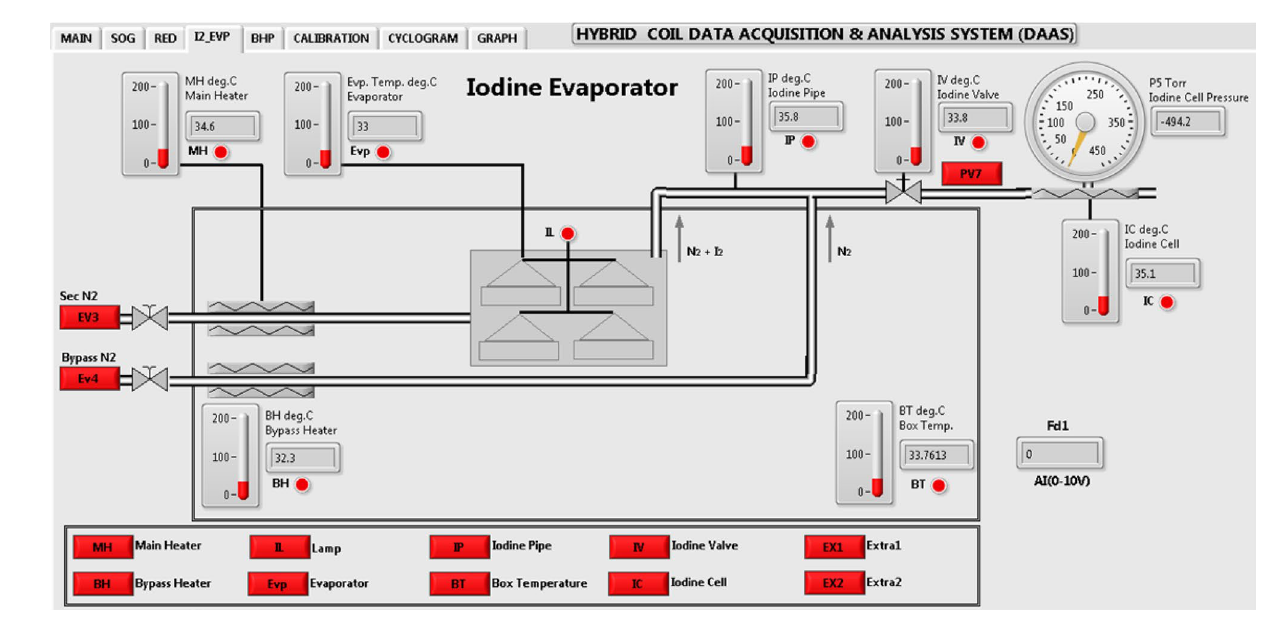
Figure 3. GUI for iodine evaporator